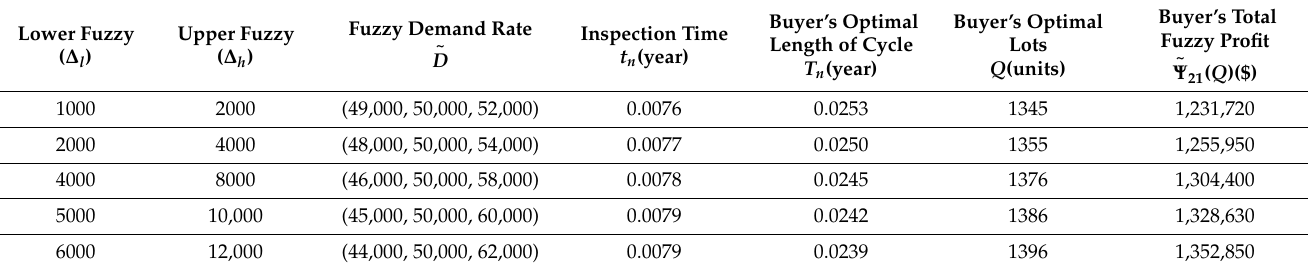
Table 6. Effect of lower fuzzy and upper fuzzy for demand on order quantity, inspection time and buyer’s profit under learning